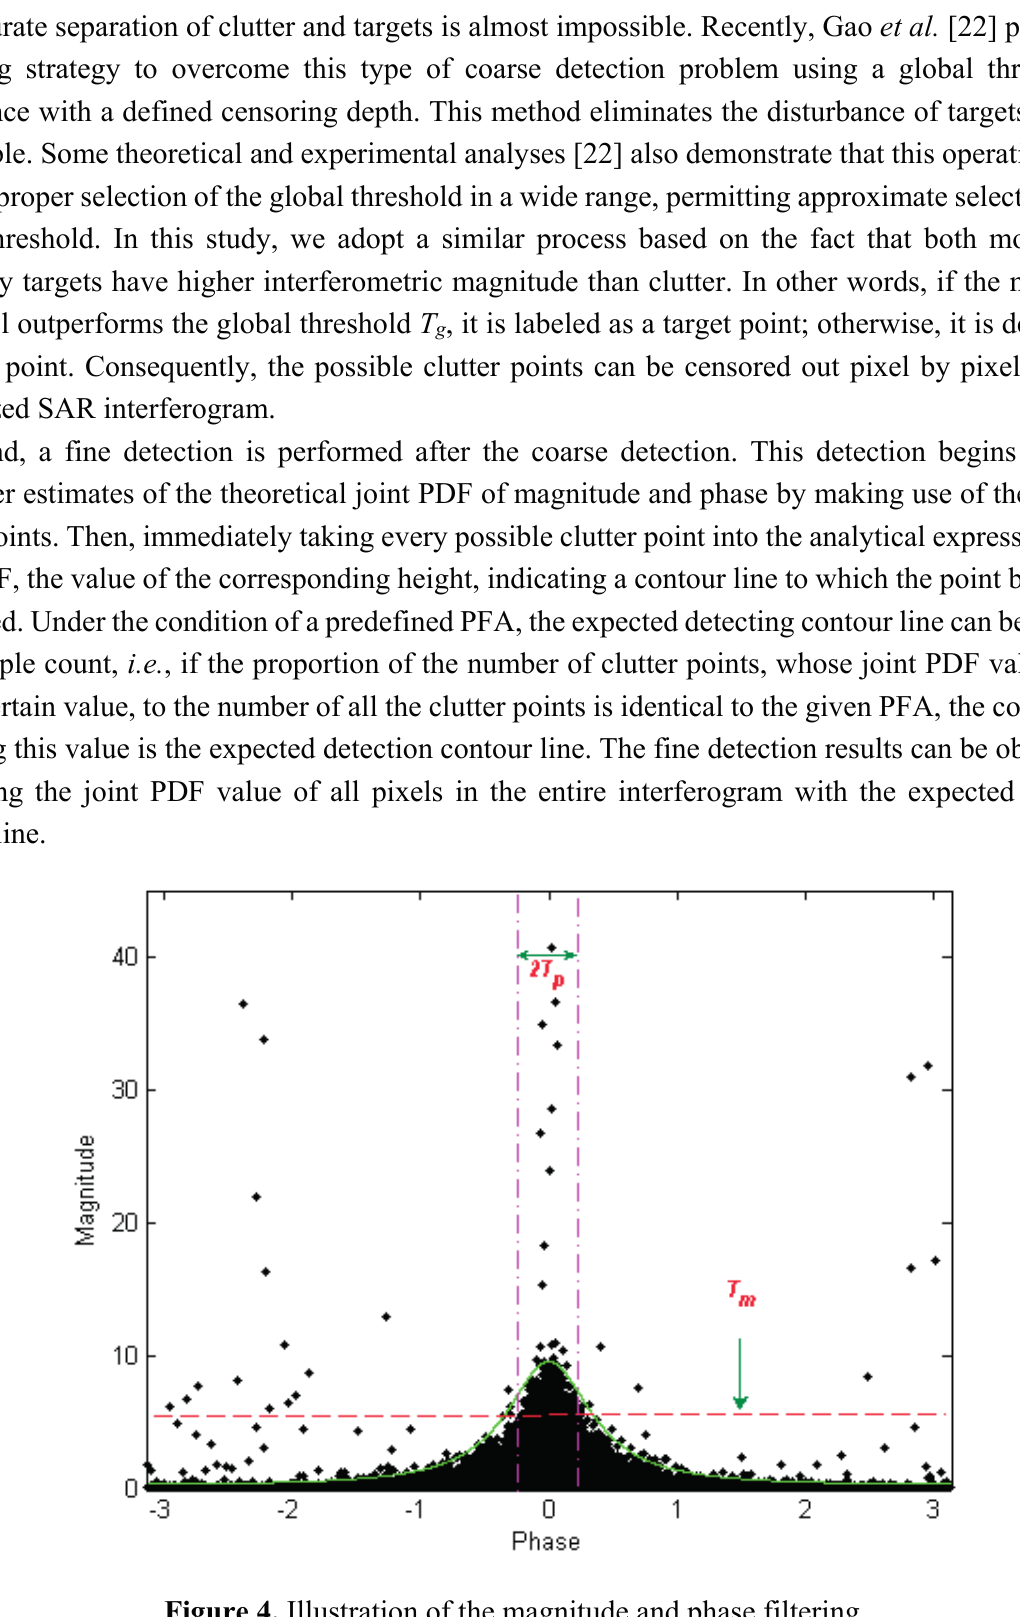
Figure 4. Illustration of the magnitude and phase